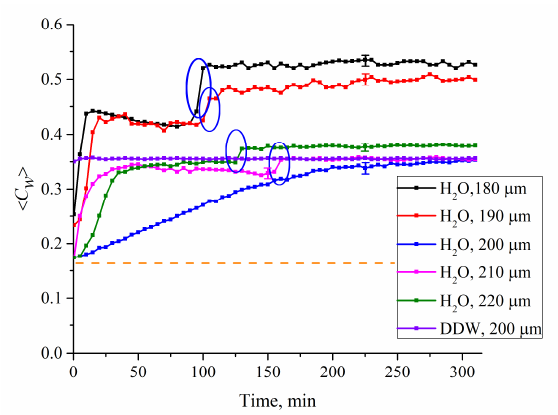
Figure 8. Average (over the distance, L , between the windows of the cell) concentration of water C w ( t ) vs. the time of swelling for various L for ordinary water. The graphs are related to the distances L = 180, 190, 200, 210 and 220 μm; we also show a graph for DDW for L = 200 μm. The ellipses mark “second jumps” in the dependences C w ( t ) (see the comments in the text). The dashed line is water concentration for dry Nafion (baseline).